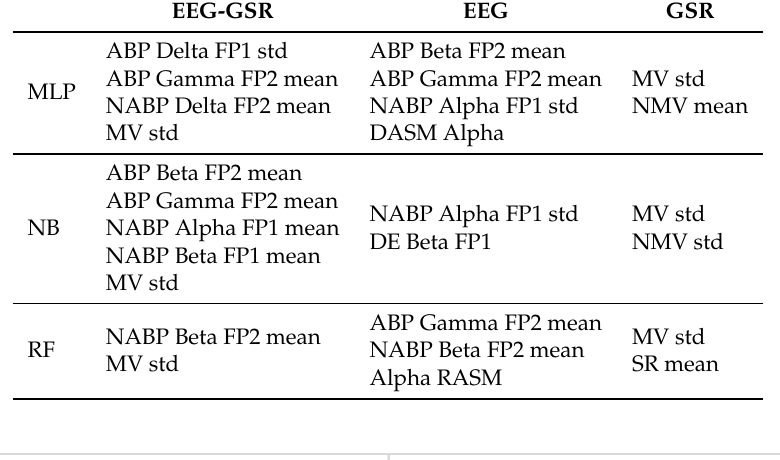
Table 9. Selected features by WSE in each model.